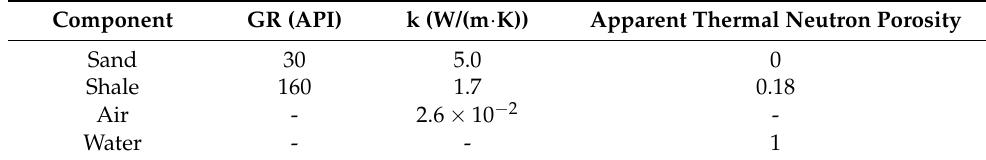
Table 1. The response parameter and the TC value of each component used in the logging data. Component GR (API) k (W/(m · K)) Apparent Thermal Neutron Porosity Sand 30 5.0 0 Shale 160 1.7 0.18 Air - 2.6 × 10 − 2 - Water - -